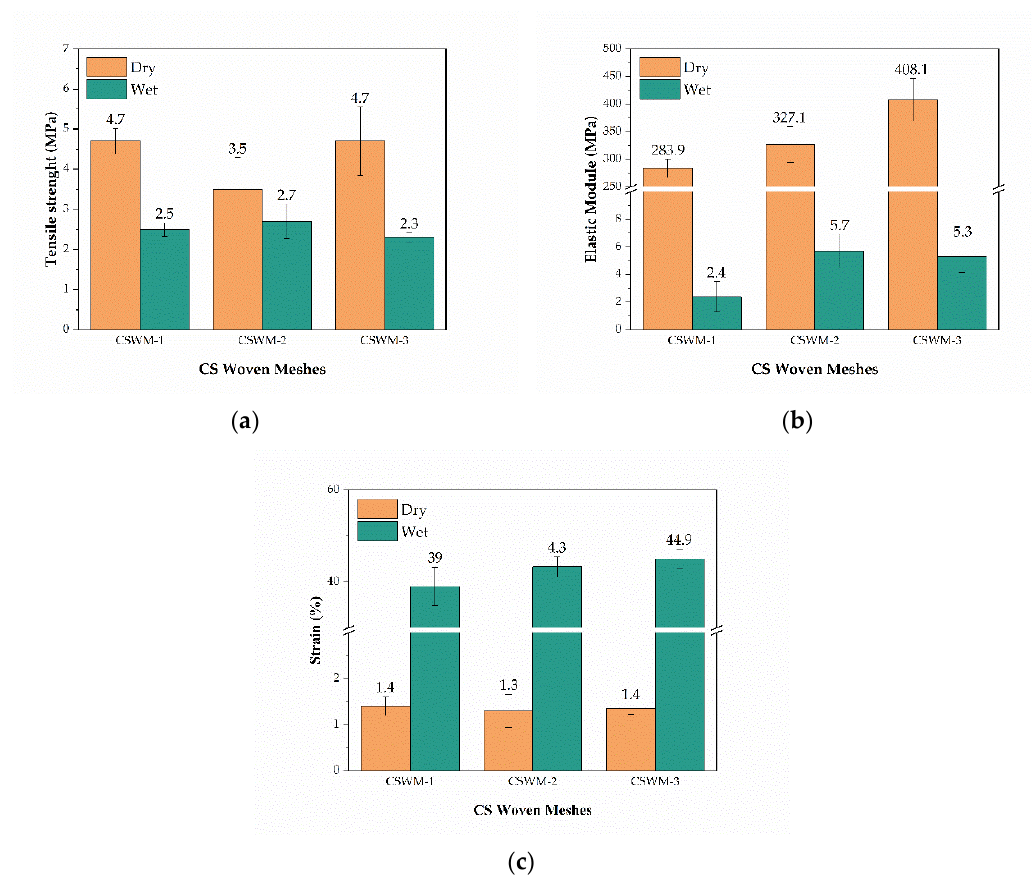
Figure 7. Comparison of ( a ) tensile strength, ( b ) elastic module, and ( c ) strain at break of dry and hydrated chitosan woven meshes (mean ± standard deviation).